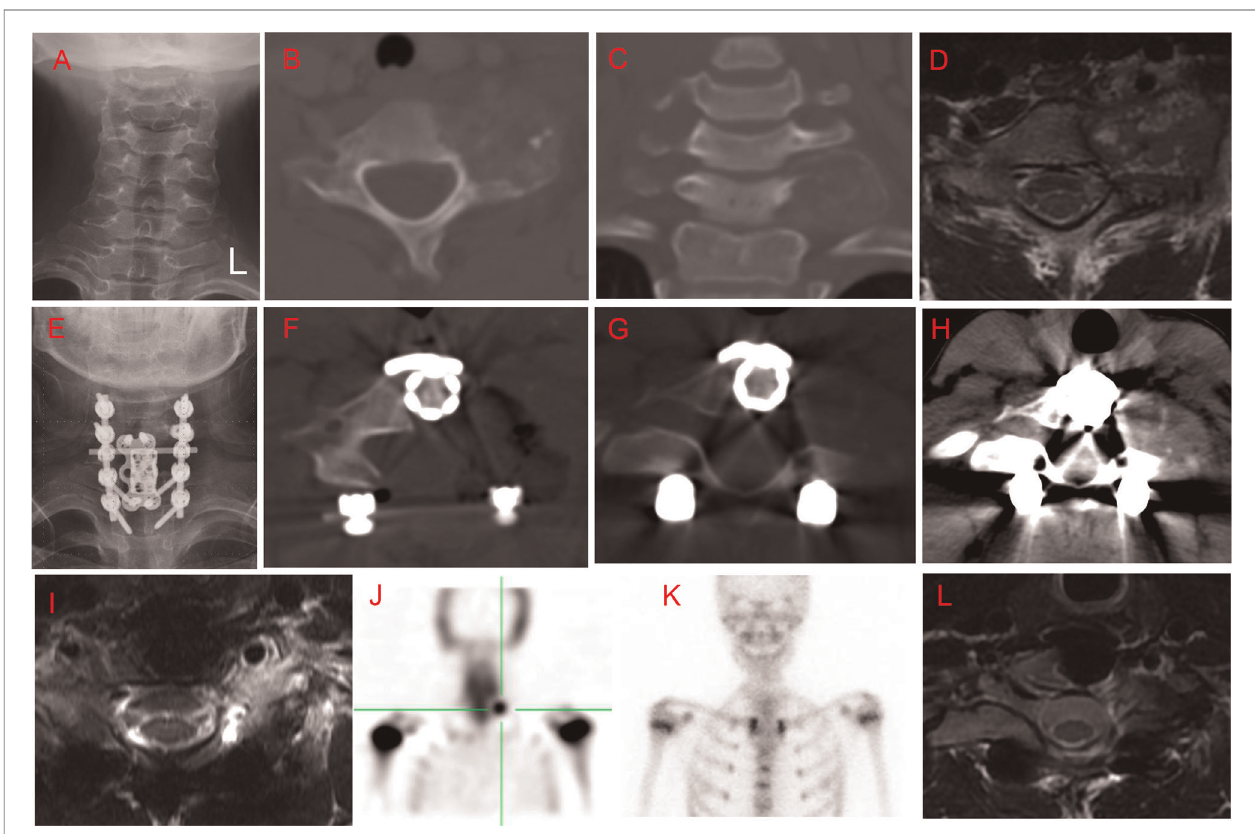
FIGURE 2 | Case 5. A 15-year-old male patient with local neck and night pain for 6 months. An osteolytic lesion was located in the C7 vertebral body, left pedicle, transverse process, and lateral mass, with left vertebral artery extension. He underwent intralesional marginal resection; however, positron emission tomography- computed tomography (PET-CT) 7 months postoperatively showed local recurrence. The patient underwent a second surgery through a posterior approach. There was no further recurrence at a 5-year follow up after the second surgery. ( A ) Preoperative posteroanterior radiography. ( B,C ) Preoperative axial and coronal computed tomography (CT) scans. ( D) : T2-weighted magnetic resonance imaging (MRI) scan. ( E ) Posteroanterior radiography 1 week after the fi rst surgery. ( F ). Axial CT scan 1 week after surgery. ( G,H ) Axial CT scan 7 months after surgery. ( I ) T2-weighted MRI scan 7 months after surgery. ( J ) Isotope bone scan 7 months after surgery. ( K ) Isotope bone scan 3 years after the second surgery. ( L ) T2-weighted MRI scan 5 years after the second